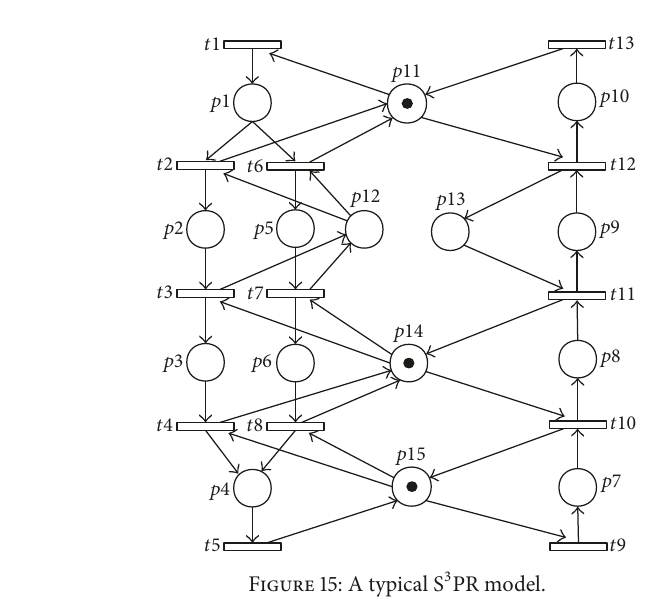
Figure 15: A typical S 3 PR model.